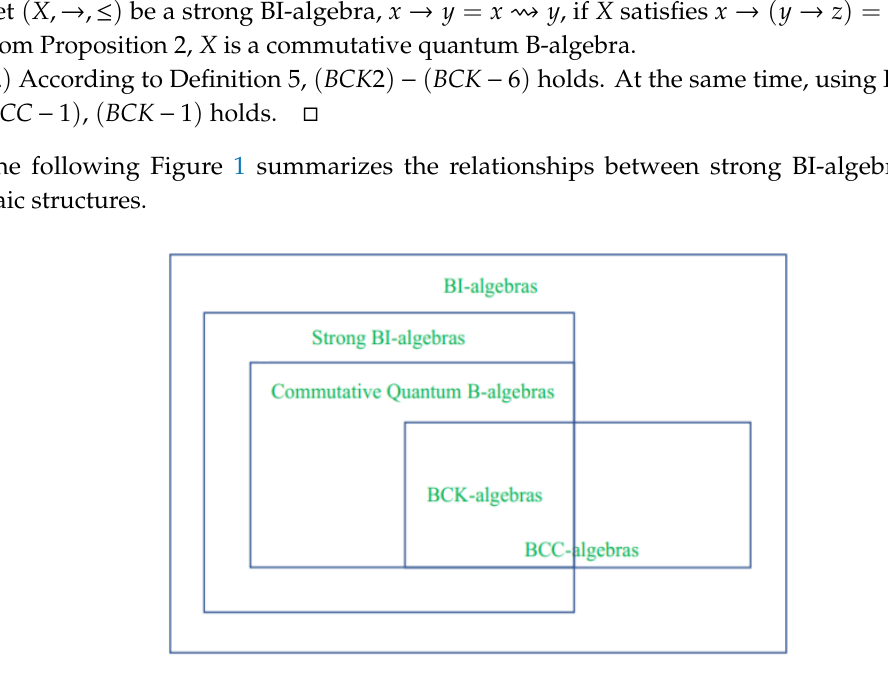
Figure 1. The relationships among strong BI-algebra and some algebraic